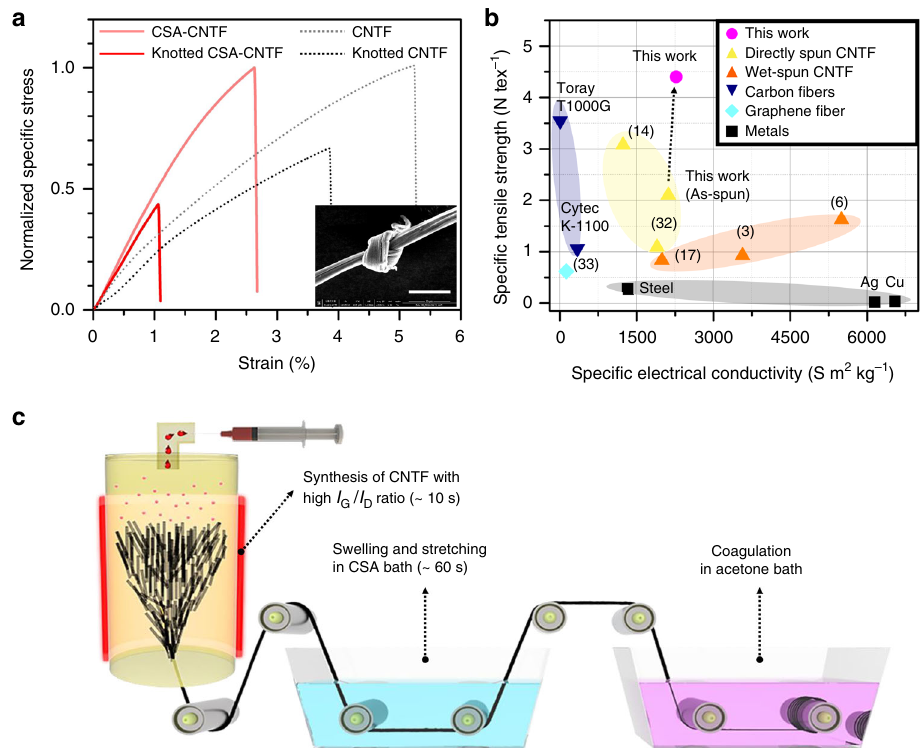
Fig. 7 Excellent properties of densi fi ed CNTFs and proposed spinning method. a Normalized speci fi c stress-strain curves of CNTF, knotted CNTF, CSA- CNTF, and knotted CSA-CNTF. b Ashby plot of speci fi c tensile strength versus speci fi c electrical conductivity of directly spun CNTFs (yellow triangles) 14,32 , wet-spun CNTFs (orange triangles) 3,6,17 , carbon fi bers (navy inverted triangles) 27 , graphene fi ber (cyan diamond) 33 , metals (black squares), and CNTFs from this work (magenta circle). c Proposed potentially continuous spinning method for highly densi fi ed and aligned CNTFs. The scale bar in ( a ) is 10 μ